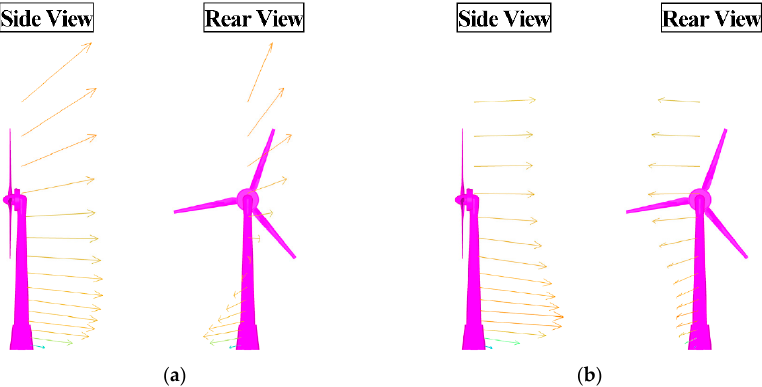
Figure 9. Instantaneous velocity vectors at WT No. 3. ( a ) Time = 106.0, marked by point C in Figure 8, ( b ) Time = 107.5, marked by point D in Figure 8.